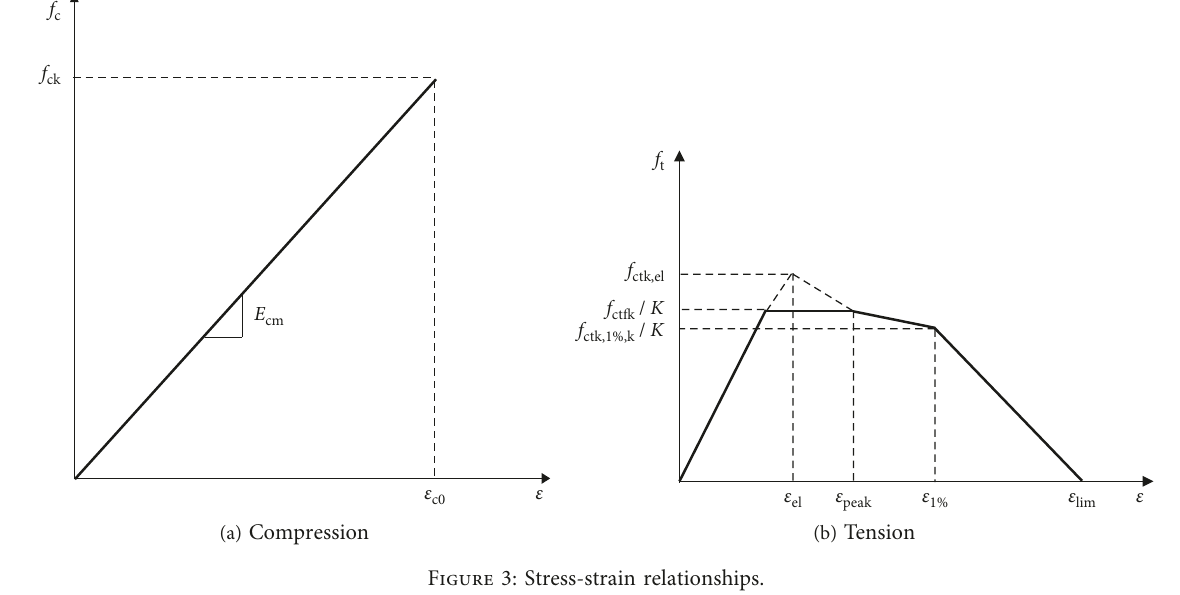
Figure 3: Stress-strain relationships.